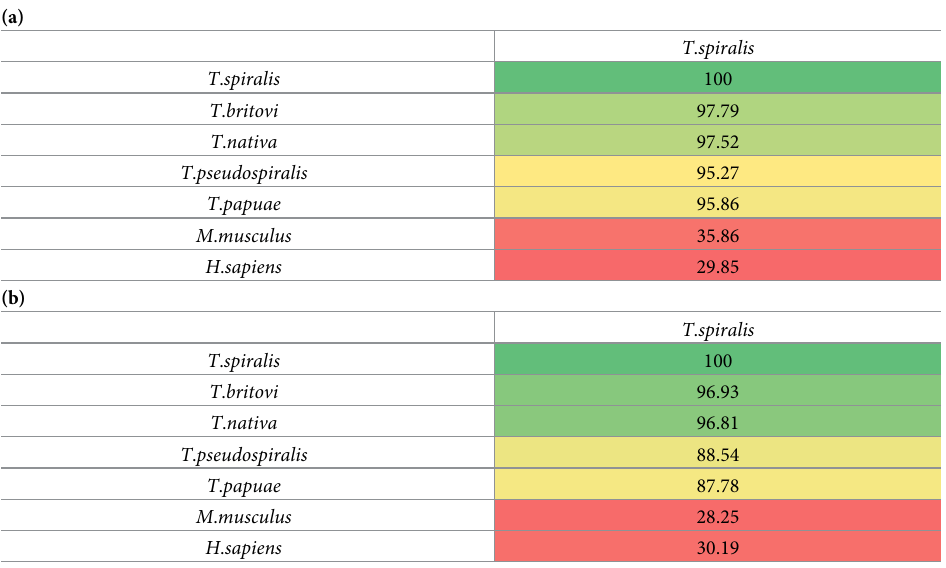
Table 4. The percent similarity of protein sequence alignment of peroxidasin-like protein (a) and PX domain pro- tein (b) among Trichinella spp ., Mus musculus and Homo sapiens . All protein sequences were retrieved from the non-redundant protein sequence database of the NCBI. The sequence alignments and identity calculations were per- formed using the Clustal Omega